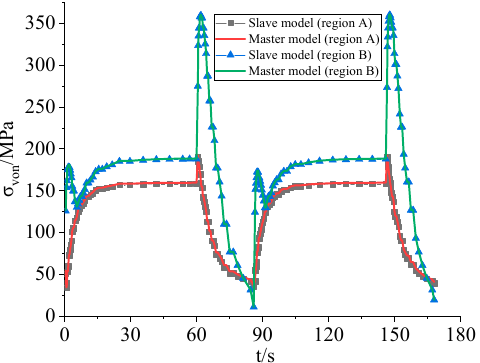
Figure 16. Comparison of maximum thermal stress in the TC layer by different models in regions A and B.